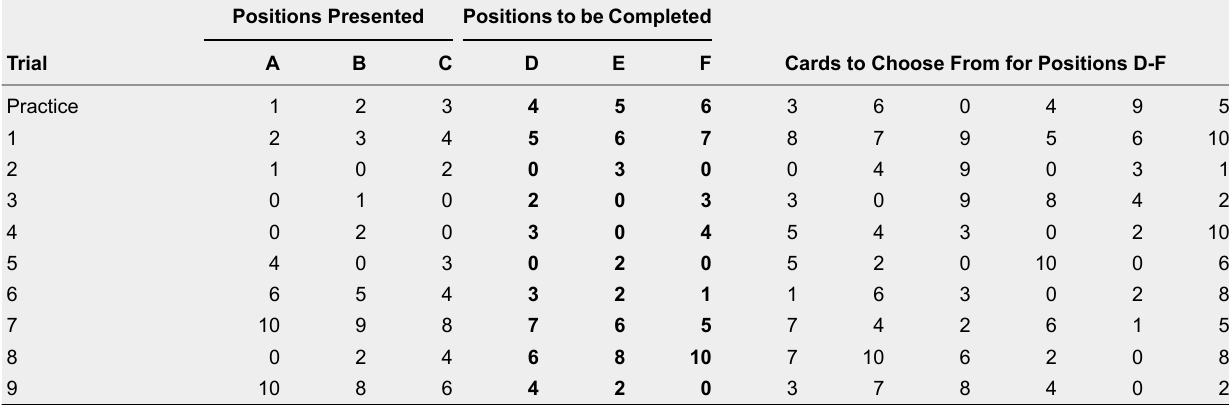
Overview of the Trials of the Quantity Sequence Test